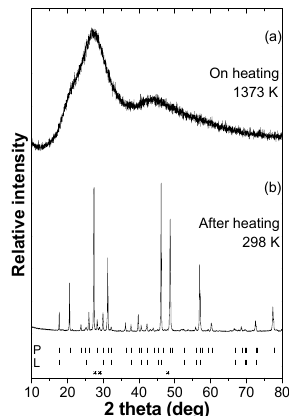
Figure 2. The XRD pattern of the melted materials of pyromorphite. Upper ( a ), on heating at T = 1373 K; lower ( b ), after heating at T = 298. Key to peaks label abbreviations: p = pyromorphite (Pb 10 (PO 4 ) 6 Cl 2 ); L = lead phosphate (Pb 3 (PO 4 ) 2 ); * is indexed as the peaks from lead dioxide (PbO 2 ).